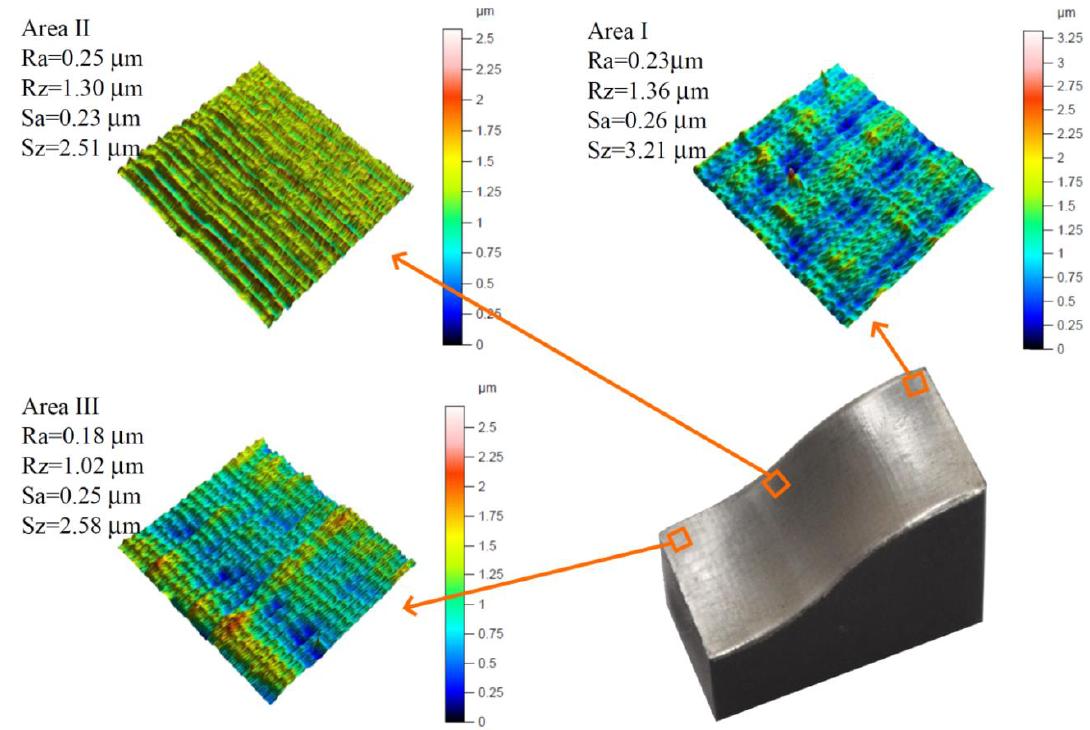
Figure 14. Isometric views of the machined surface using the proposed method.